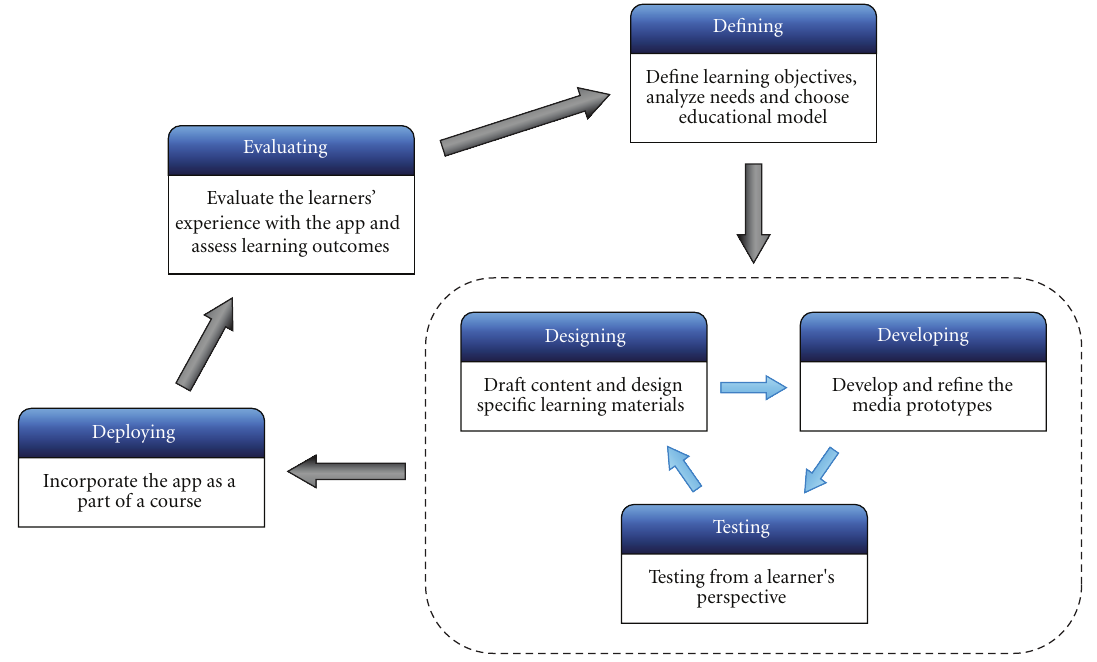
Figure 1: Laurillard’s learning design process.